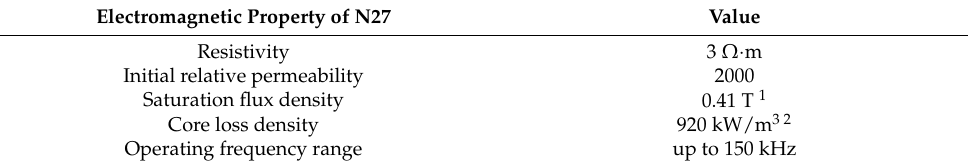
Table 4. Several properties of ferrite N27.